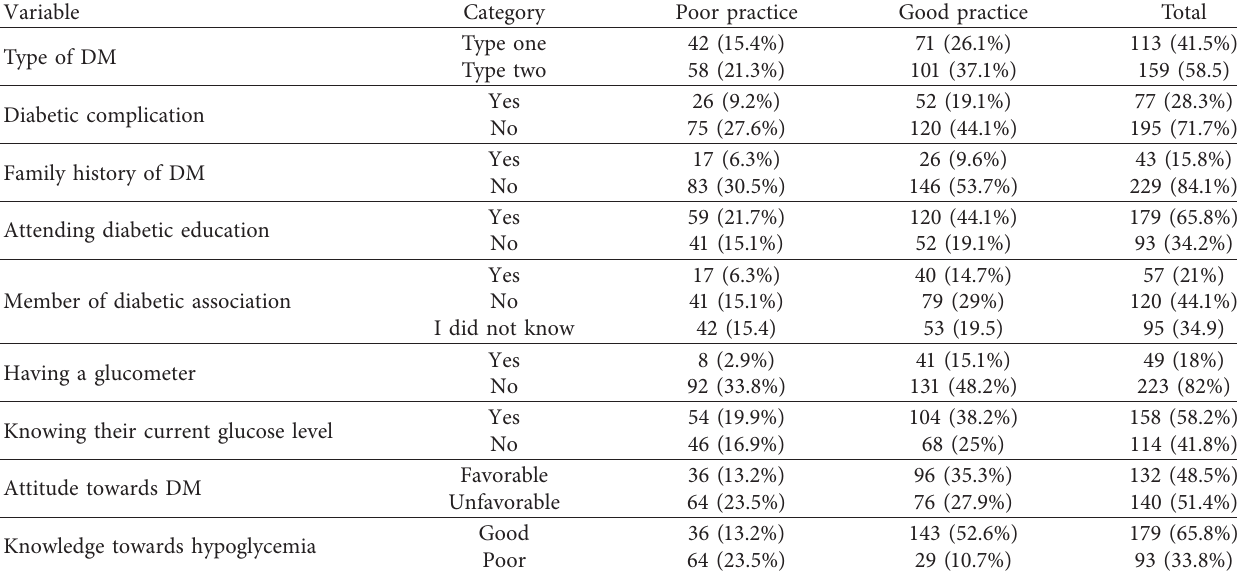
Table 2: Health profile, knowledge, and attitude towards hypoglycemia prevention practice among patients with diabetes mellitus at public hospitals, central zone, Tigray, Ethiopia,